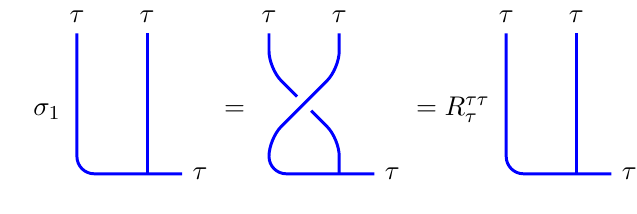
Figure 11 . Construction of σ 1 , the lone generator of B 2 . Here R ττ